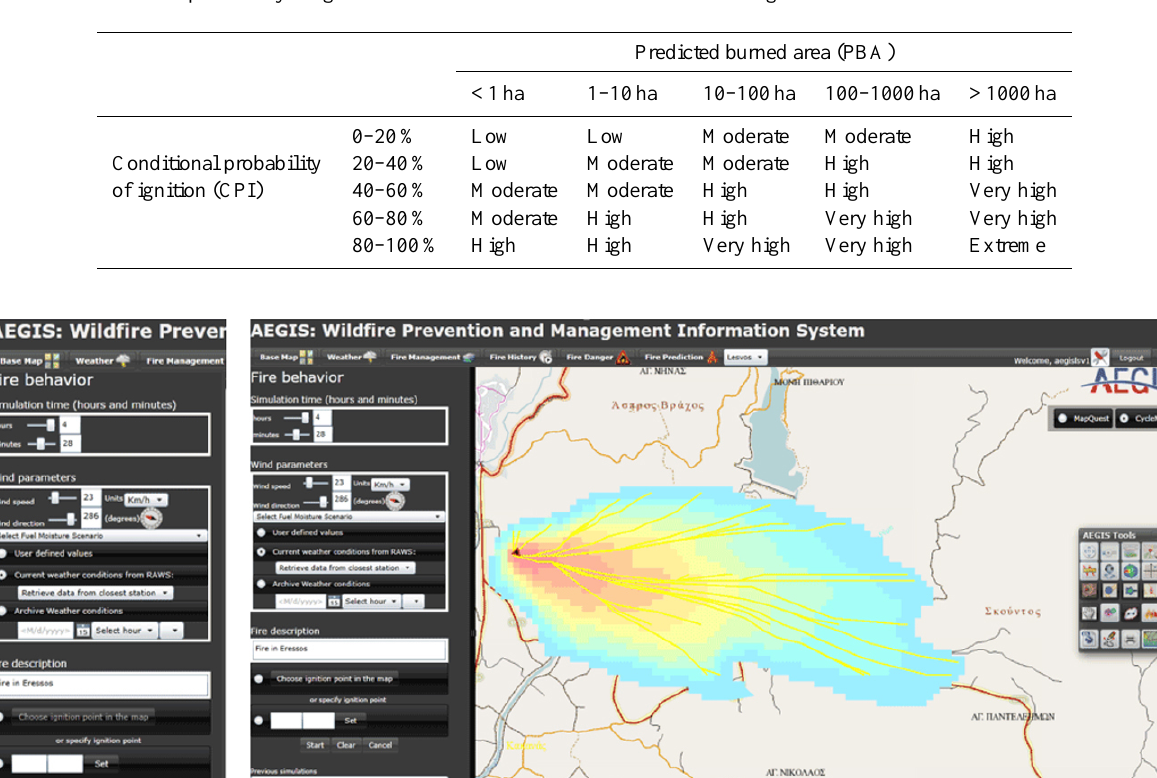
Table 4. Union matrix of probability of ignition and burned area to derive fire hazard ratings.